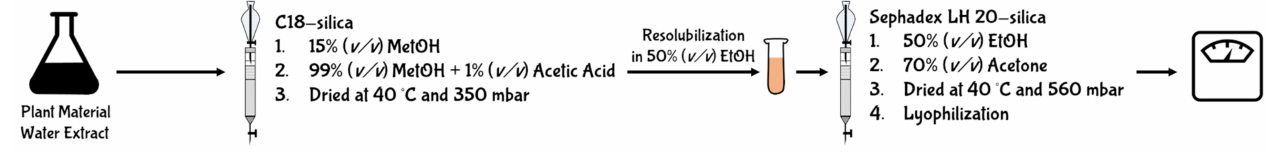
Figure 7. Schematic representation of the gravimetric method for the quantification of